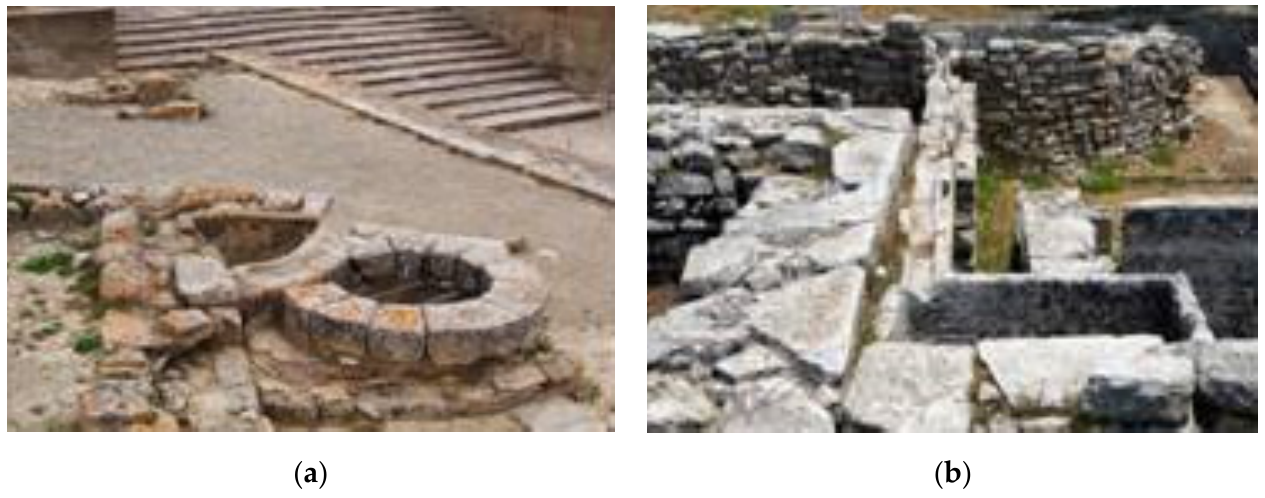
Figure 1. ( a ) Special cistern with coarse sandy filter and ( b ) small stone-made cistern used as sedimentation of suspended solids in Tylissos (Photos A.N. Angelakis).